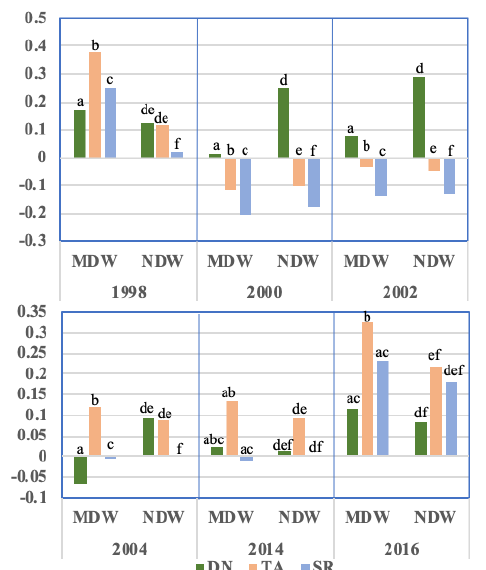
Figure 8. Modified Normalized Difference Water Index (MDW) and Normalized Difference Water Index (NDW) of the edge water class for three pre-processing levels (DN, TA, SR) across Table 3. P-values from years that exhibited an insignificant six years. Letters denote significant difference (p<0.05) between difference (p >0.05) between select indices calculated from DN, pre-processing levels within a given index. Average index TA, and SR pre-processing levels. Bold numbers denote values for pre-processing levels were not compared across insignificant p-values. different indices.